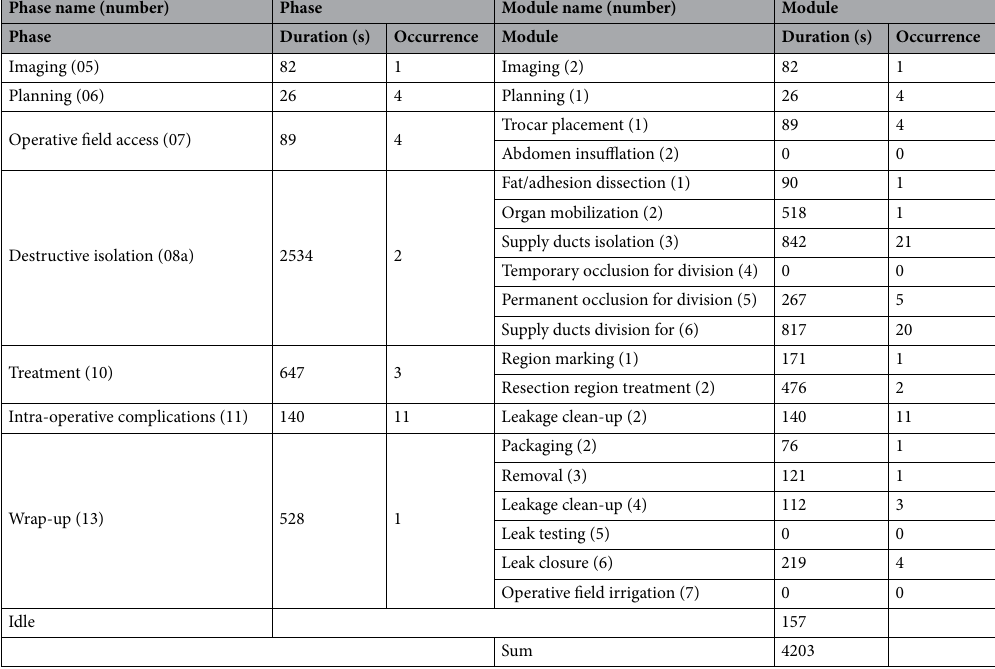
Table 2. The results of analysis on the data extracted from the endoscopic video in the both granularity levels of module and phase for a sample surgery (type: parenchyma sparing of a tumor in Segments 5 and 6 presented in Supplementary material-part